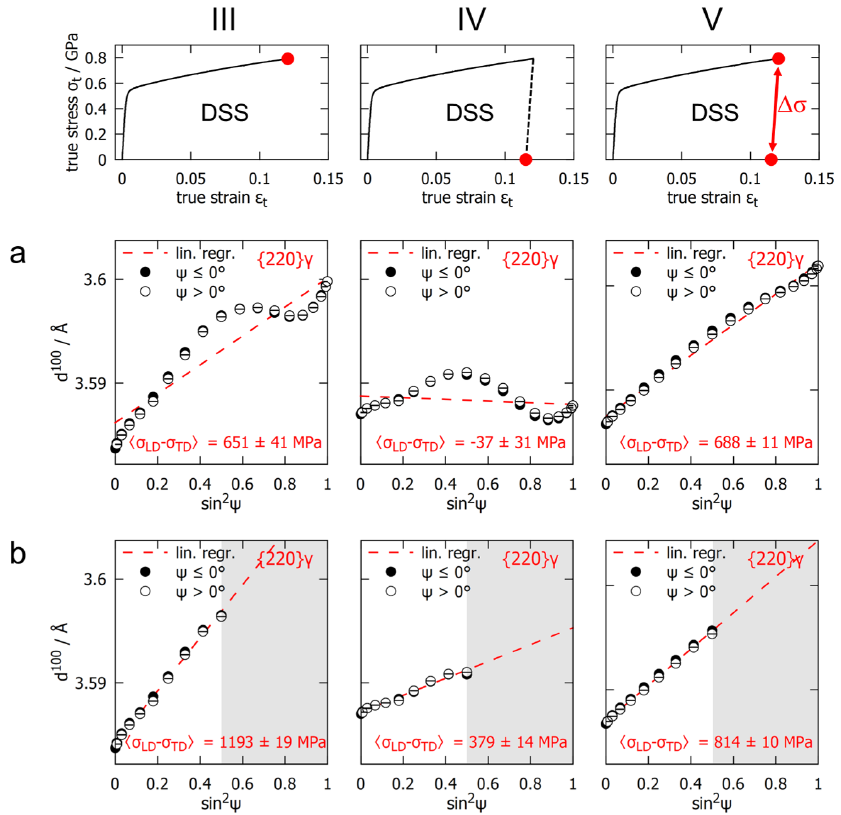
Figure 11. d 100 -sin 2 ψ plots for the { 220 } γ lattice planes of the DSS for the deformed state ( III ), ϕ , ψ deformed state after unloading ( IV ) and the difference between loaded and unloaded state ( V ); stress evaluation is performed considering the full sin 2 ψ range 0 ≤ sin 2 ψ ≤ 1 ( a ) and considering only the lower half 0 ≤ sin 2 ψ ≤ 0.5 for demonstration purposes ( b